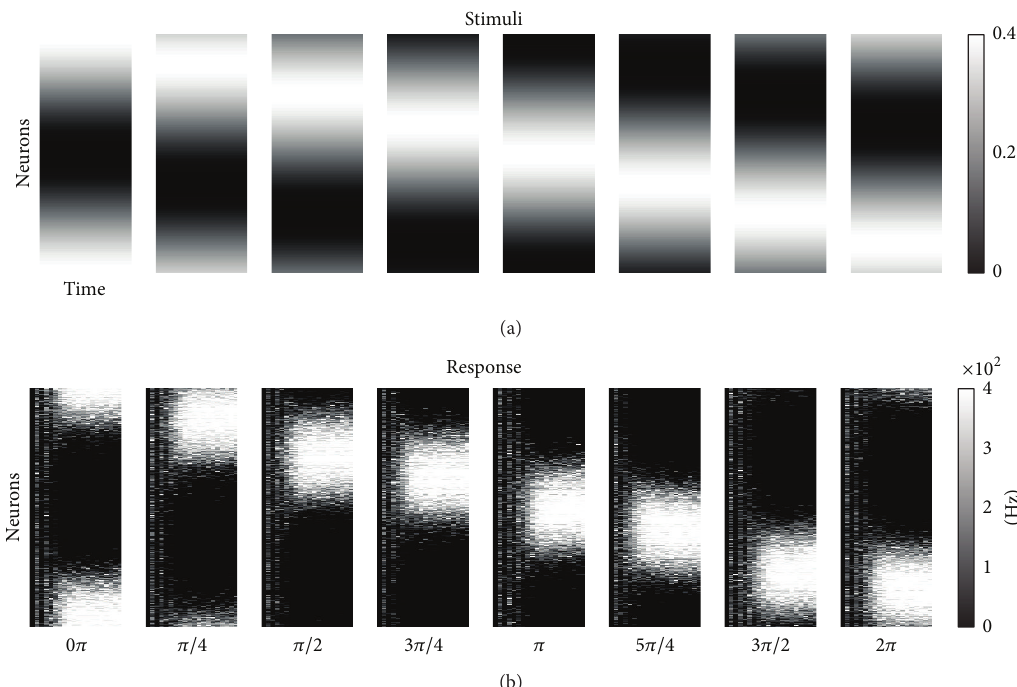
Figure1:Simulateddatageneratedfromtheorientationtuningmodel.Foreachof8directionalstimuliprovidedtoeachneuron(a),simulated neuronal responses are generated (b). Horizontal axis for each box represents time-flow (for 200 ms, from left to right), and vertical axis represents single neurons. Magnitude of stimulation and neuronal response is represented by a greyscale colormap.